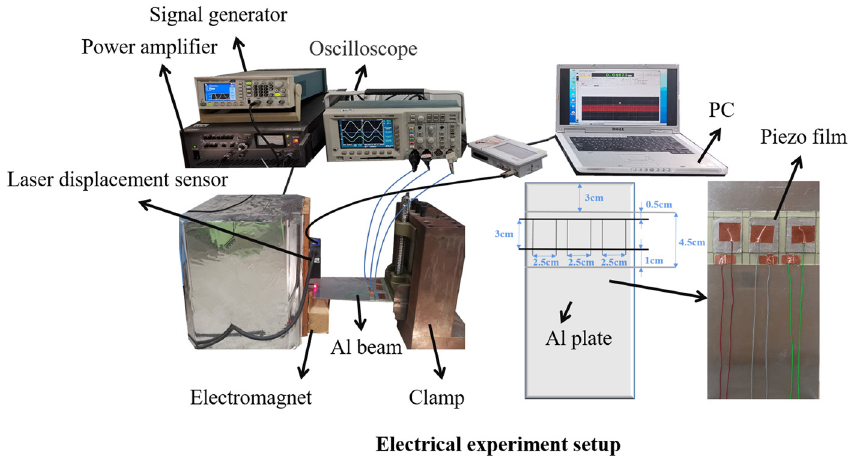
Figure 3: Measurement setup of the open circuit